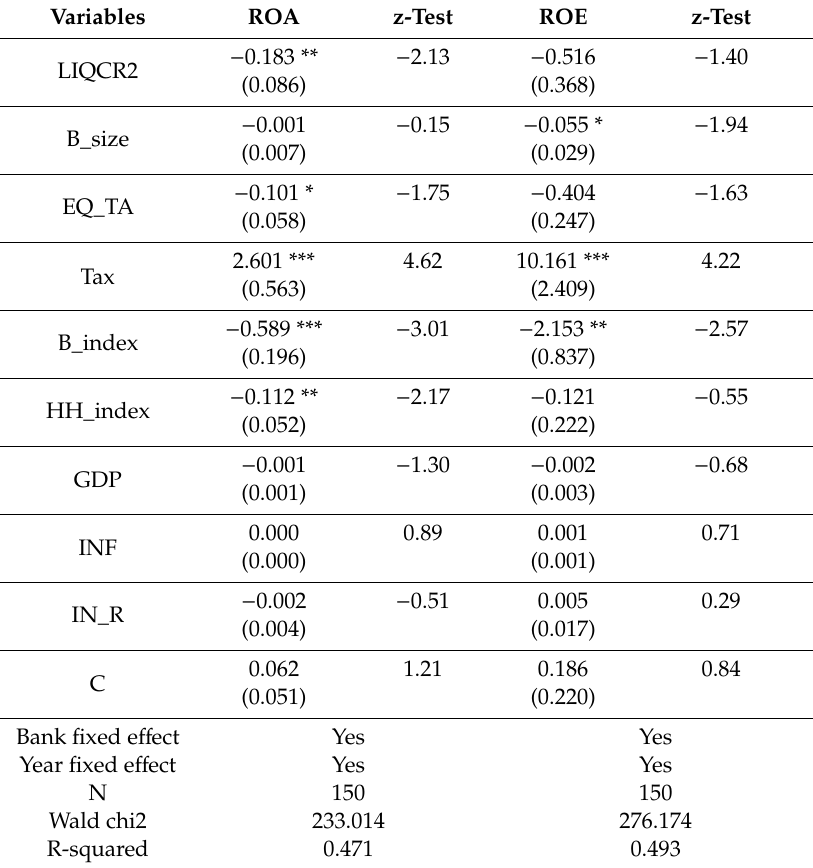
Table 9. Liquidity creation and bank profitability—using an alternative measure of liquidity